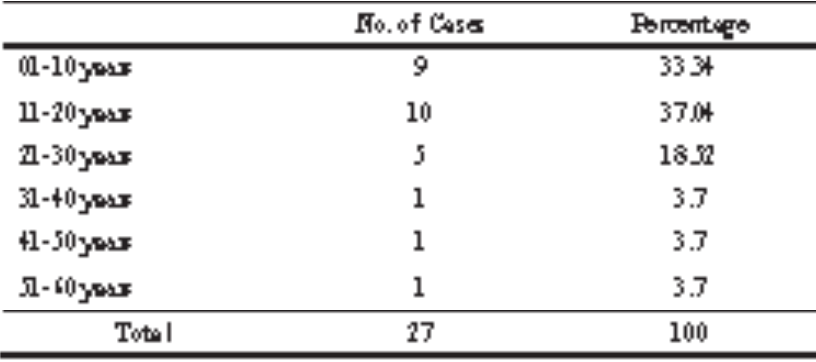
Table I: Age group distribution